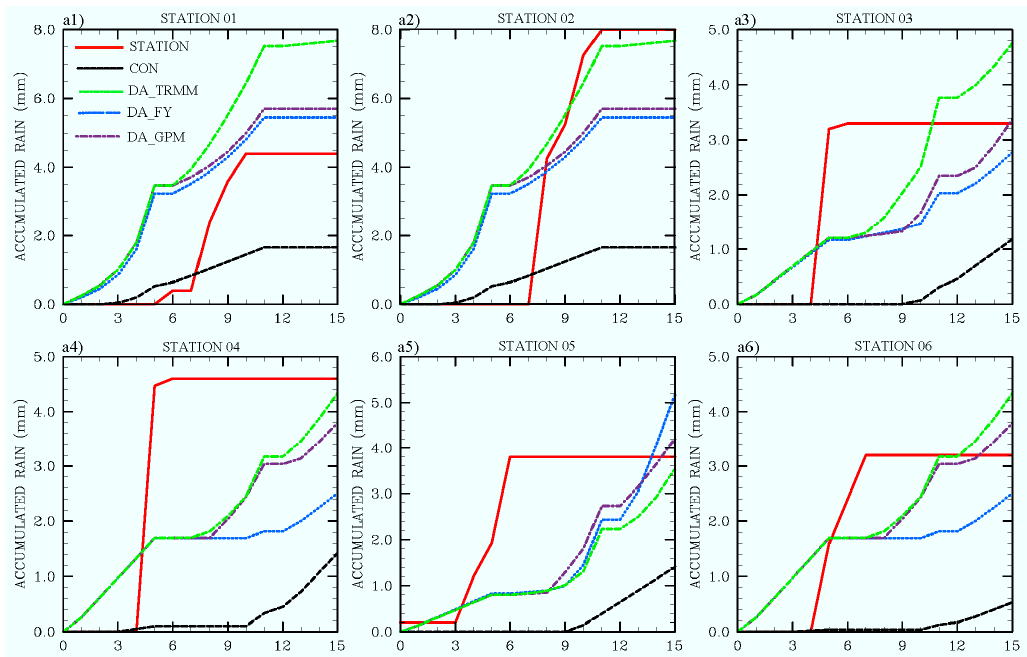
Figure 13. Comparisons of accumulated rainfall curves for the control simulation, TRMM assimilation, FY assimilation, and HiWATER super stations (from 00:00 UTC to 15:00 UTC on 1 July 2015): (a1–a6) from station 01 to station 06.